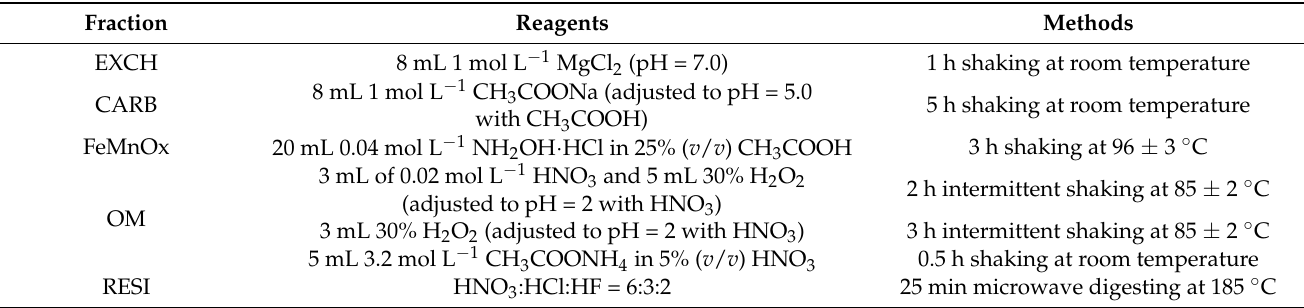
Table 3. Detailed steps of the Tessier continuous extraction